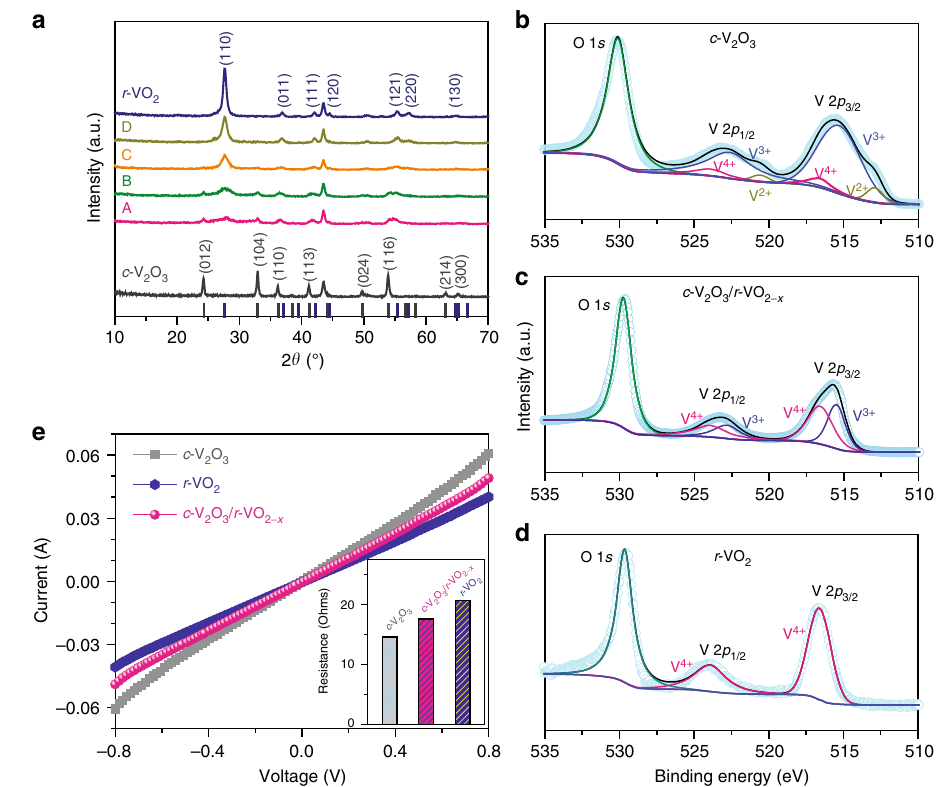
Fig. 3 Chemical analysis and electrical properties. a XRD patterns for NP c -V 2 O 3 , r -VO 2 and c -V 2 O 3 / r -VO 2 − x fi lms, demonstrating the evolution of phase transformation via thermal oxidation of the corundum c -V 2 O 3 at 300 °C for 10 (A), 20 (B), 30 (C) and 60 min (D), respectively. The line patterns show reference cards 34 – 0187 and 44 – 0253 for the pristine c -V 2 O 3 and r -VO 2 according to JCPDS. b – d XPS spectra of O 1 s , and V 2 p for NP c -V 2 O 3 ( a ), c - V 2 O 3 / r -VO 2 − x ( b ) and r -VO 2 fi lms ( c ), which are synthesized by thermal oxidation of the as-prepared c -V 2 O 3 fi lms for 0, 10, 90 min at 300 °C, respectively. e I – V curves and the corresponding resistances (inset) of NP c -V 2 O 3 , c -V 2 O 3 / r -VO 2 − x ( x = 0.22) and r -VO 2 fi